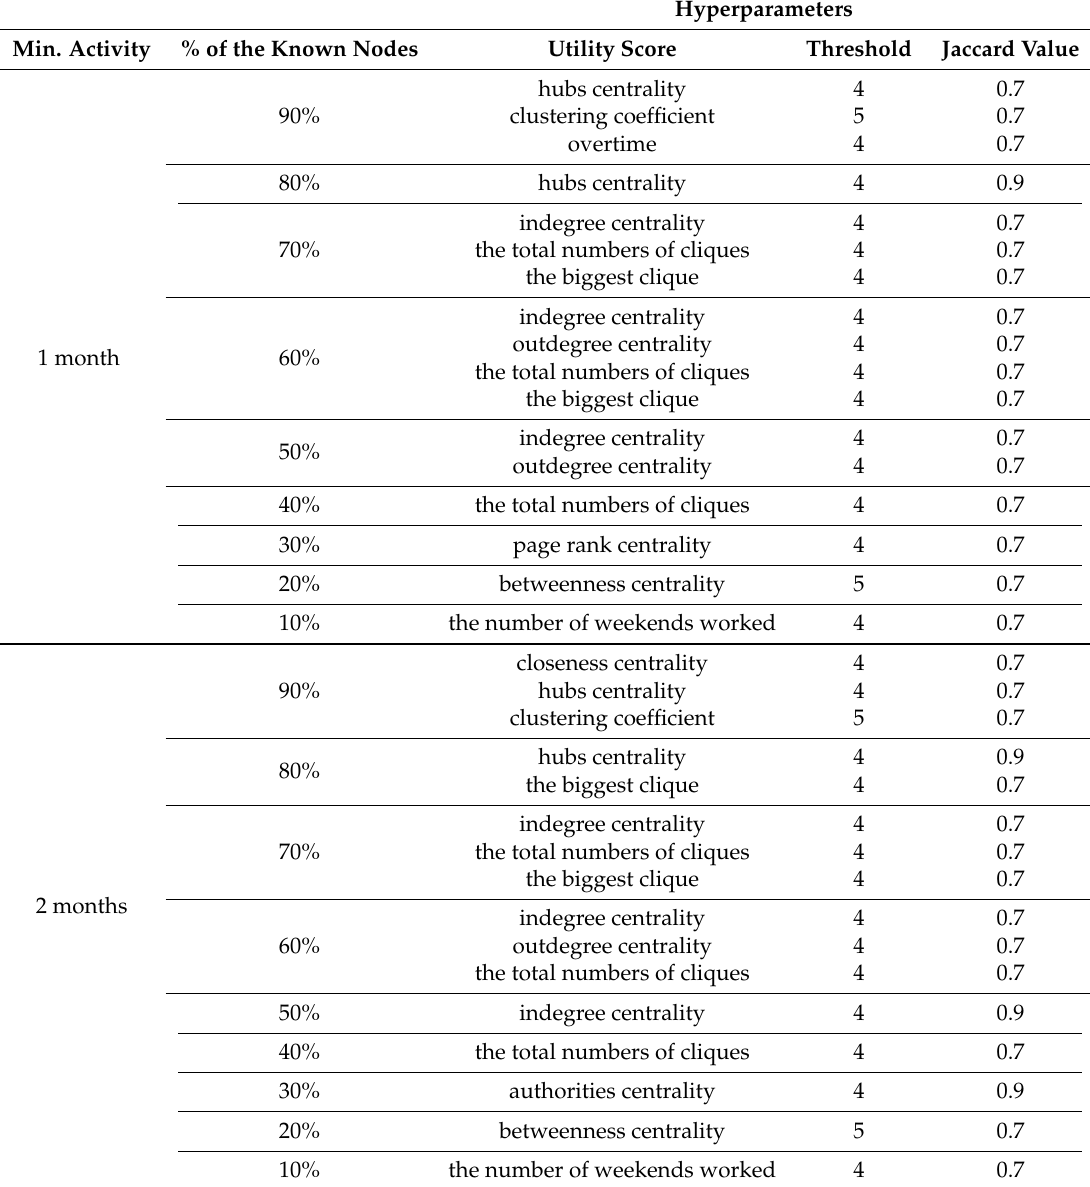
Table A27. The best values of the hyperparameters for the collective classification algorithm for the manufacturing company dataset with two hierarchy levels (1 to 3 months of minimum